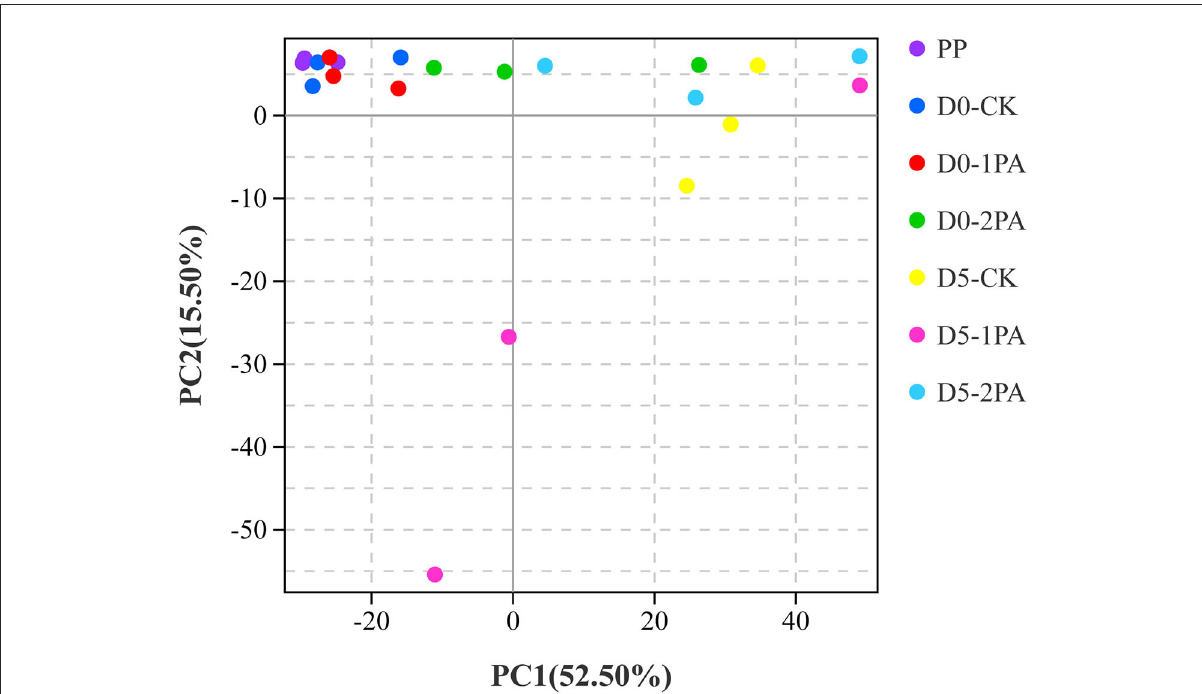
FIGURE3 Principal component analysis of fungal communities for Napier grass silages treated without or with 1 and 2% pyroligneous acid after 30 days of ensiling and 5 days of exposure to air.